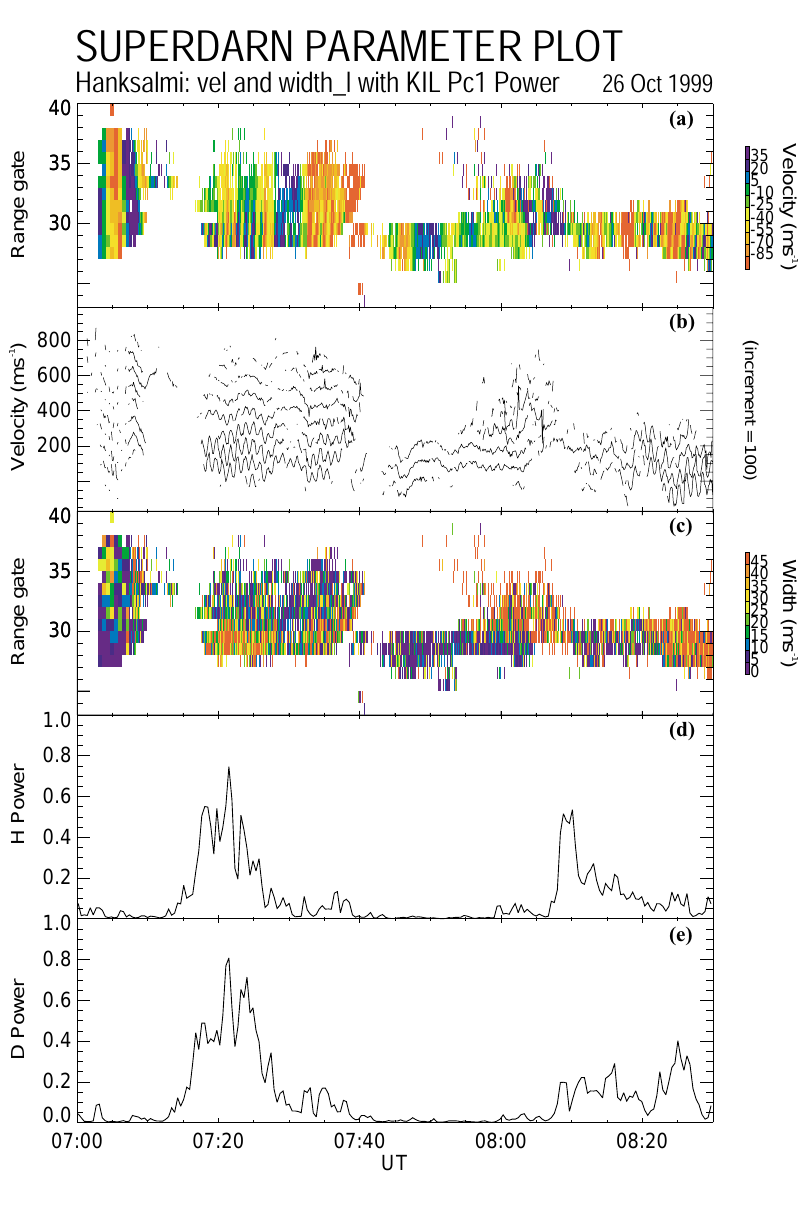
Fig. 7. OUCH measurements from 07:00–08:30UT on 26 October 1999. Panels (a–c) present the same CUT- LASS parameters as given in Fig. 3, namely (a) colour-coded line of sight velocity, (b) stacked velocity time series for range gates 26–34 and (c) colour- coded radar spectral width, all from beam 5 of the Finland radar. Also shown are time series of (d) H - and (e) D -component KIL Pc1 power summed over the frequency range 0.2–2Hz, fol- lowing the same dynamic spectral anal- ysis as shown in Fig.